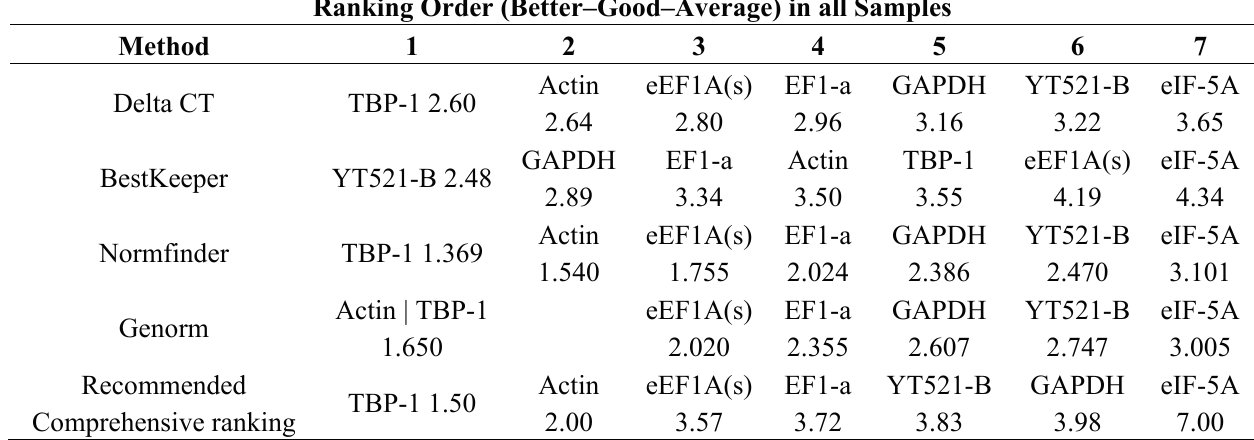
Table 4. Evaluation of the expression stabilities of candidate internal reference genes in all samples of annual